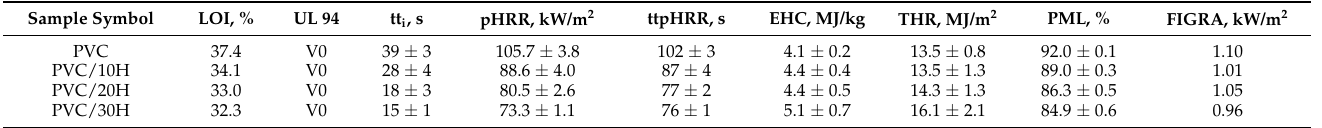
Table 8. Flammability test results of PVC composites with the addition of hop